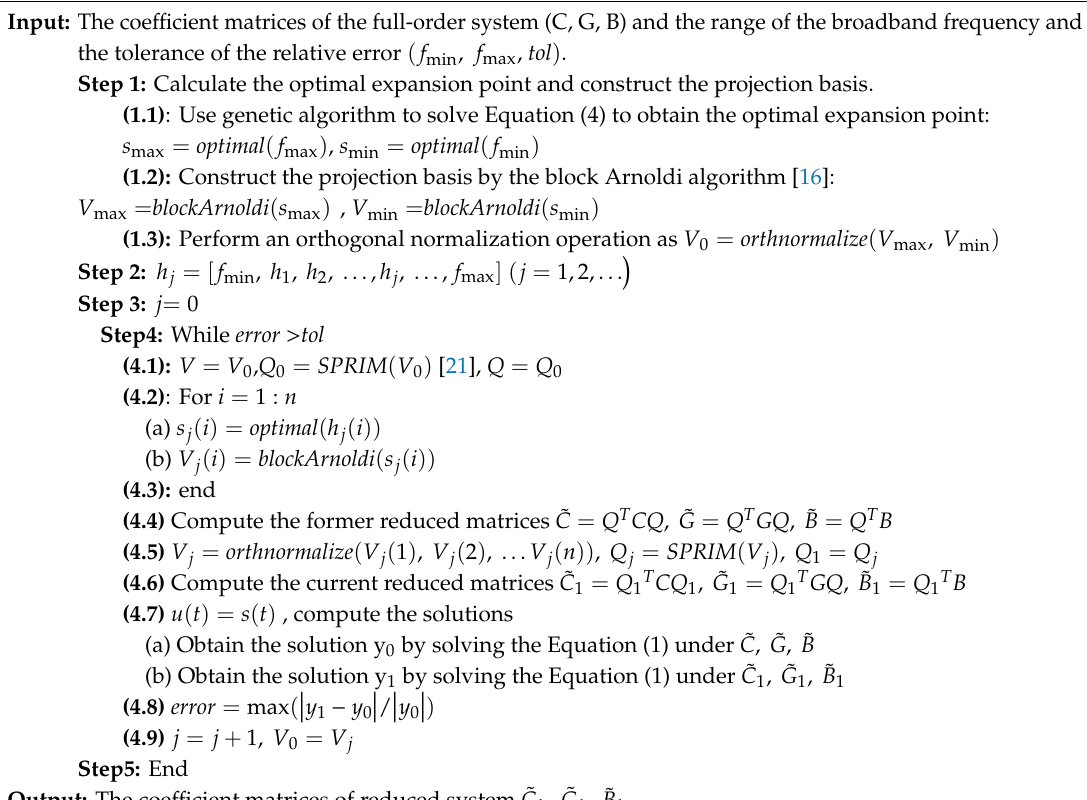
Algorithm 1: The proposed broadband enhanced SPRIM